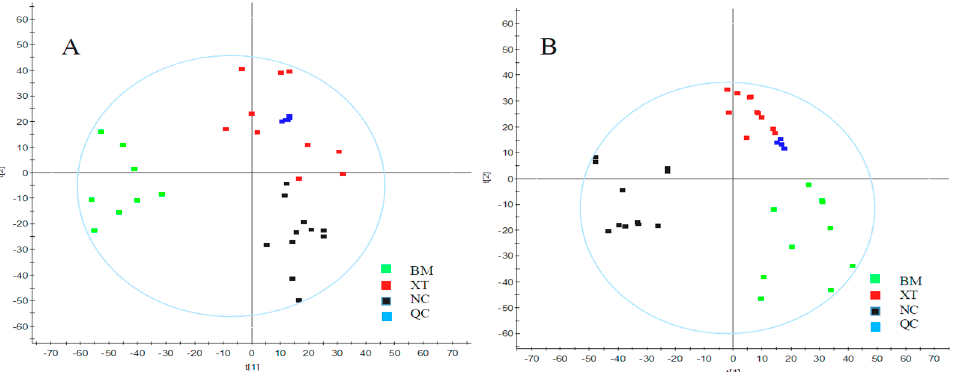
Figure 3. PCA score plots of plasma metabolic profiling of NC, BM, XT and QC in positive mode ( A ) and negative mode ( B ).